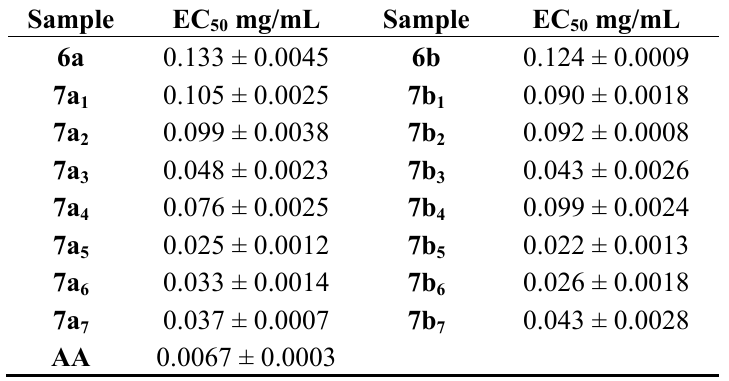
mg/mL) of the derivatives 6a , 6b , 7a 50